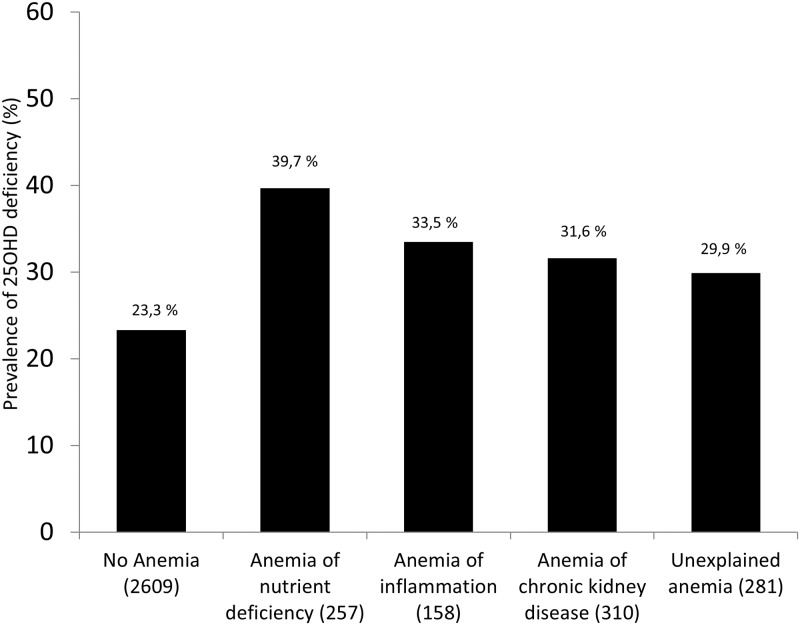
Prevalence of deficient 25OHD levels according to subtypes of anemia.There were significant differences between subgroups (P<0.001). Number of patients in brackets.